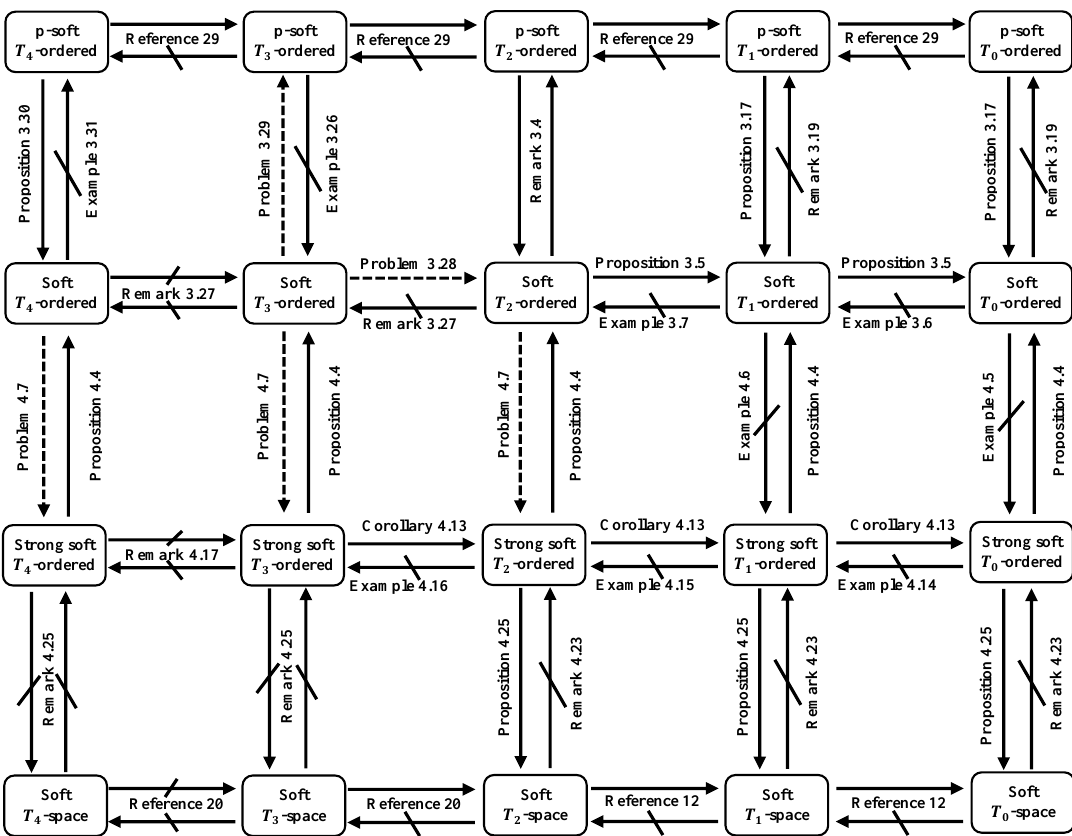
Figure 1: The relationships among some types of ordered soft separation